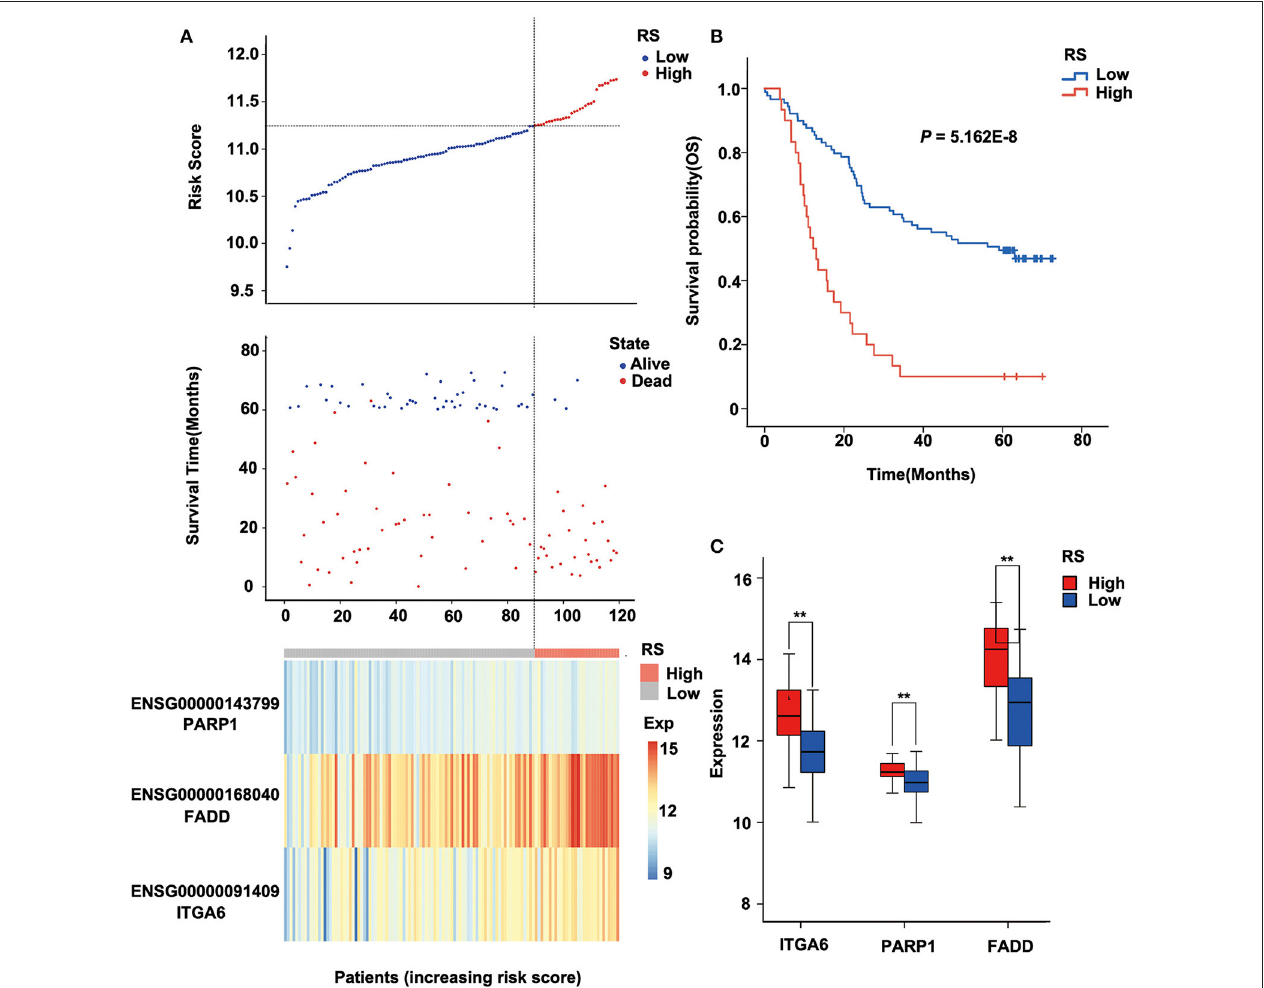
FIGURE 4 | Relation between the three-gene signature and cancer risk in the discovery cohort (GSE53624). (A) Risk score, survival time, survival state, and expression of the three ARGs in esophageal squamous cell carcinoma (ESCC) patients of GSE53624. (B) Kaplan–Meier analysis of ESCC patients grouped by risk score; log-rank Mantel–Cox test was used to compare survival curves. (C) Box plot of expression of three ARGs grouped by risk score, and the independent-sample Student t-test was used as the comparison method between the high- and low-risk groups. RS, risk score; Exp, expression. ** P <